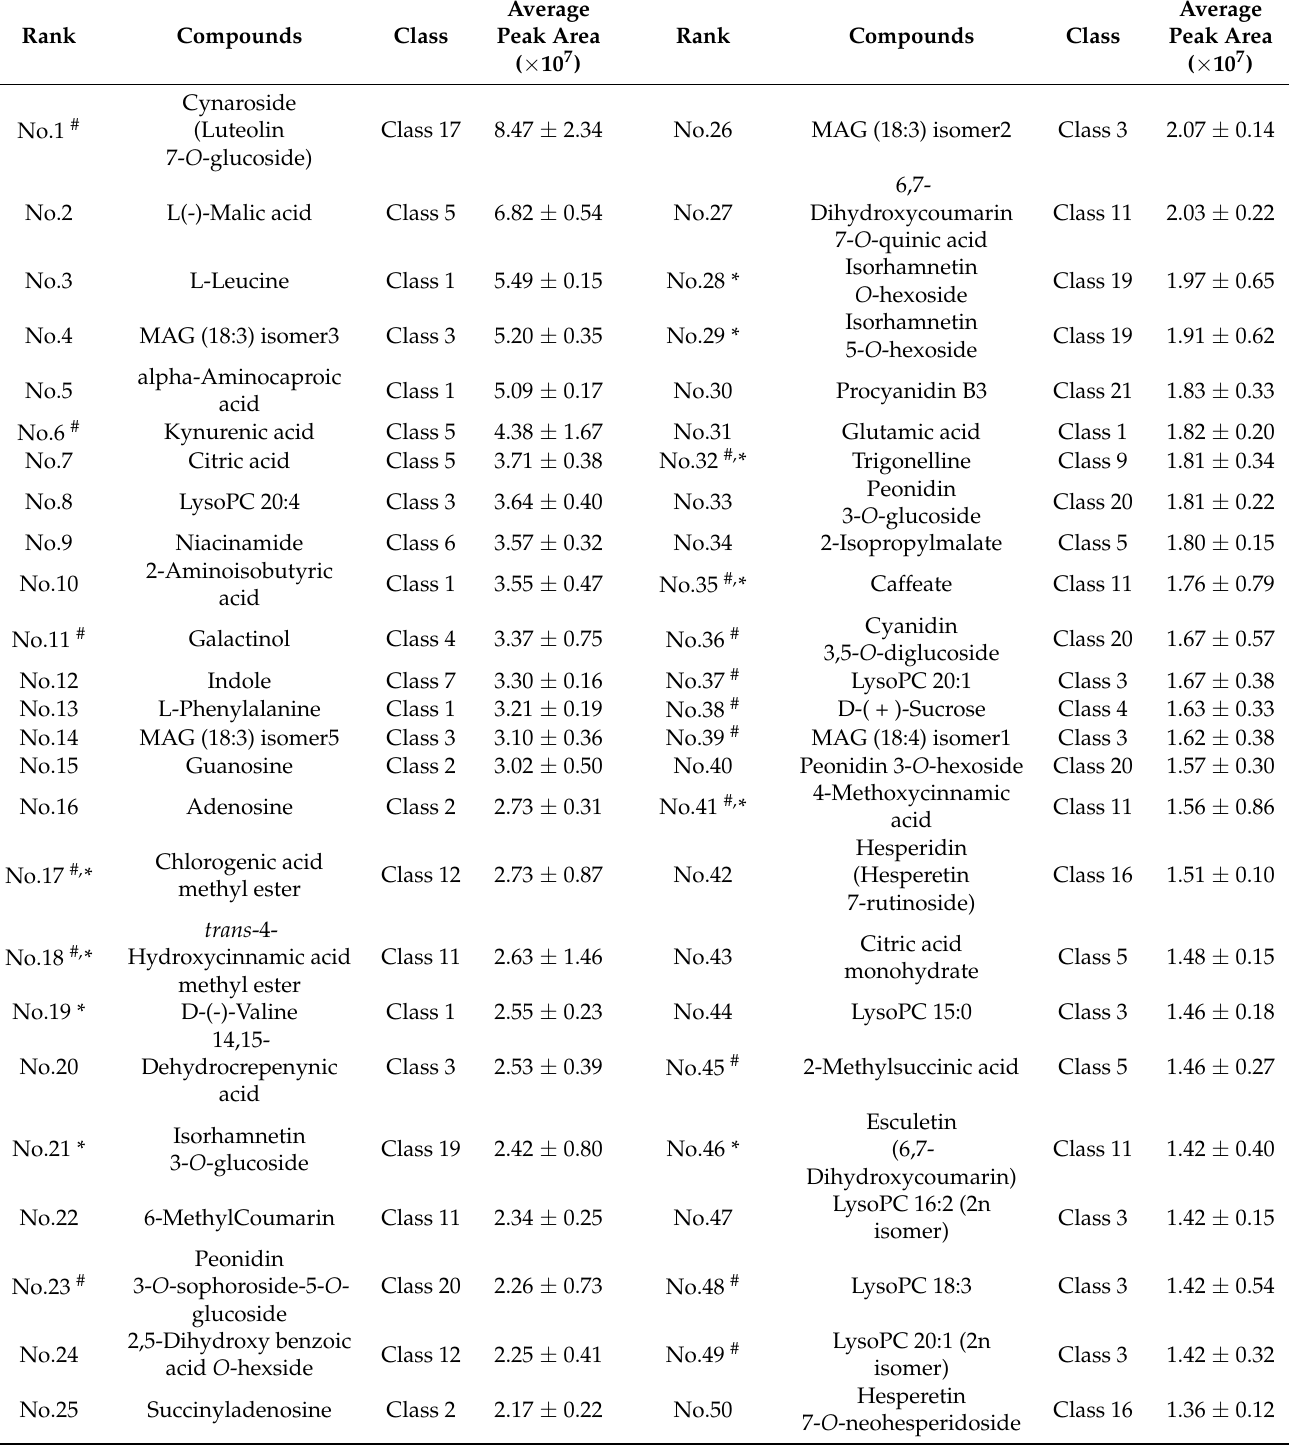
Table 2. The top 50 abundant compounds ranked by the average peak areas of all